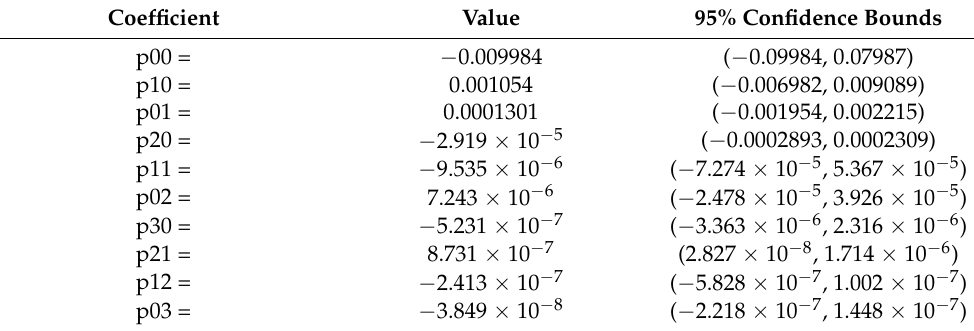
Table 4. Coefficients for Figure 8 (with 95% confidence bounds).